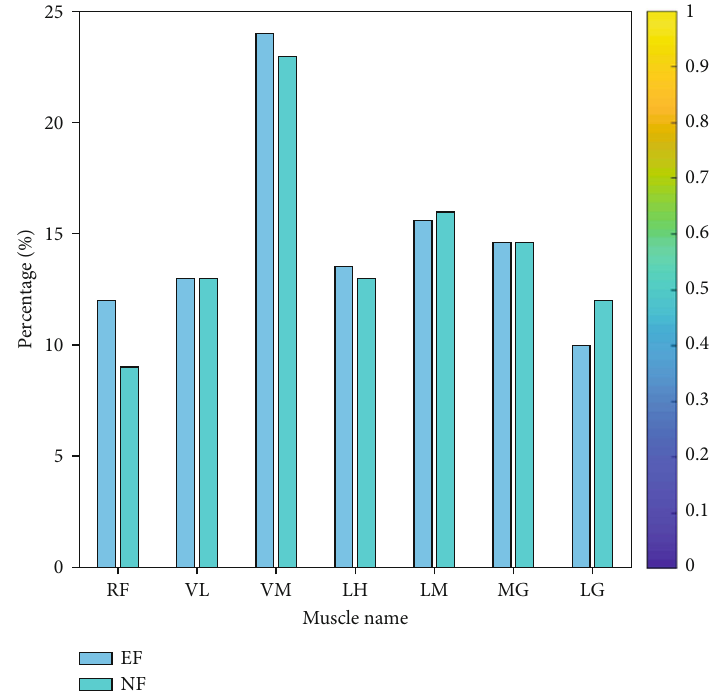
Figure 2: Comparison of muscle contribution rate between EF group and NF